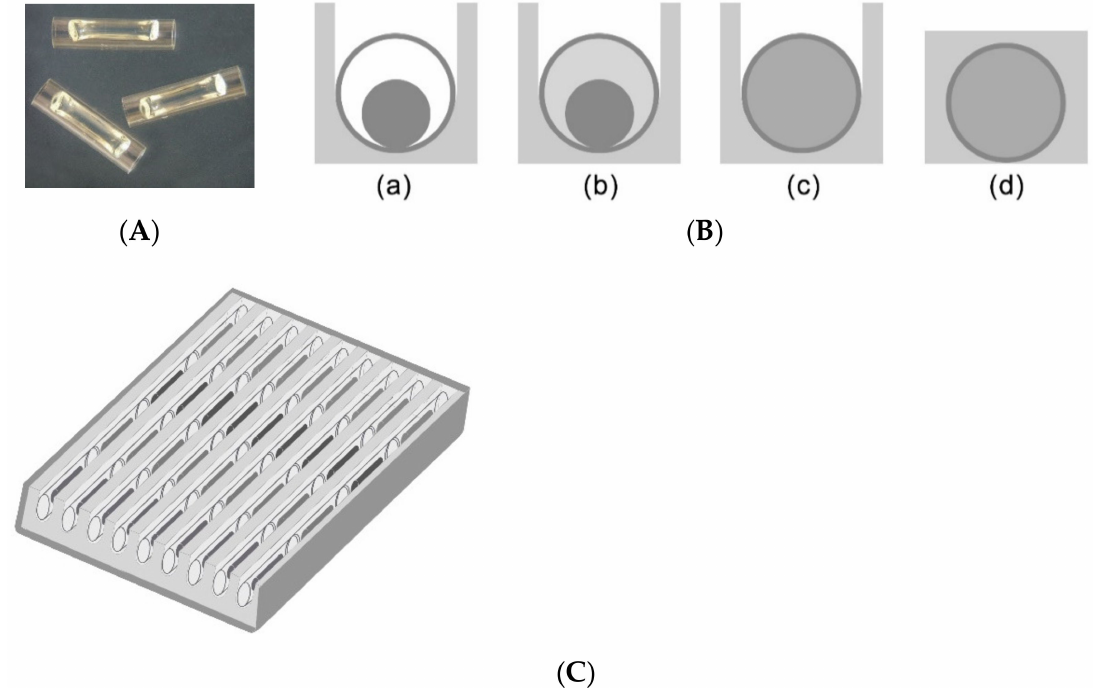
Figure 1. ( A ) Photo of capillaries (6 mm long, 1.1 mm inner diameter, ~6 µ L volume) with first polymerized and then dried gel that contains all the ingredients required for PCR. ( B ) Cross-sectional view of a capillary and wax in the cassette ( a ) the desiccated gel inside the capillary before the sample is added; ( b ) after the sample has been added; ( c ) the gel is hydrated; ( d ) capillary after the wax is melted when the cassette is heated during the PCR. ( C ) diagram of the cassette with 9 wax trenches with 4 capillaries with 4 different primer sets in each trench. Each cassette includes internal positive and negative controls.